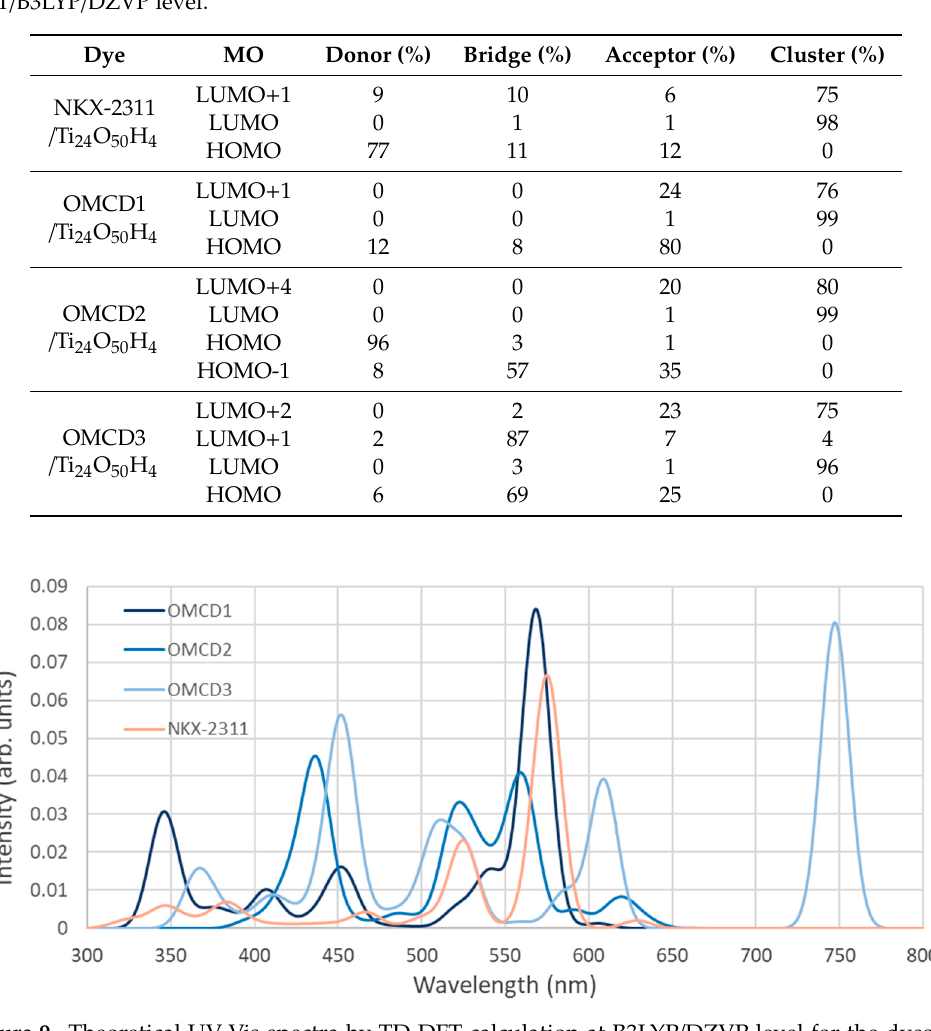
Figure 9. Theoretical UV-Vis spectra by TD-DFT calculation at B3LYP / DZVP level for the dyes on the Ti 24 O 50 H 4 cluster in ethanol. The spectral lines were convoluted with Gaussian distributions of 1000 cm − 1 linewidth at half maximum.